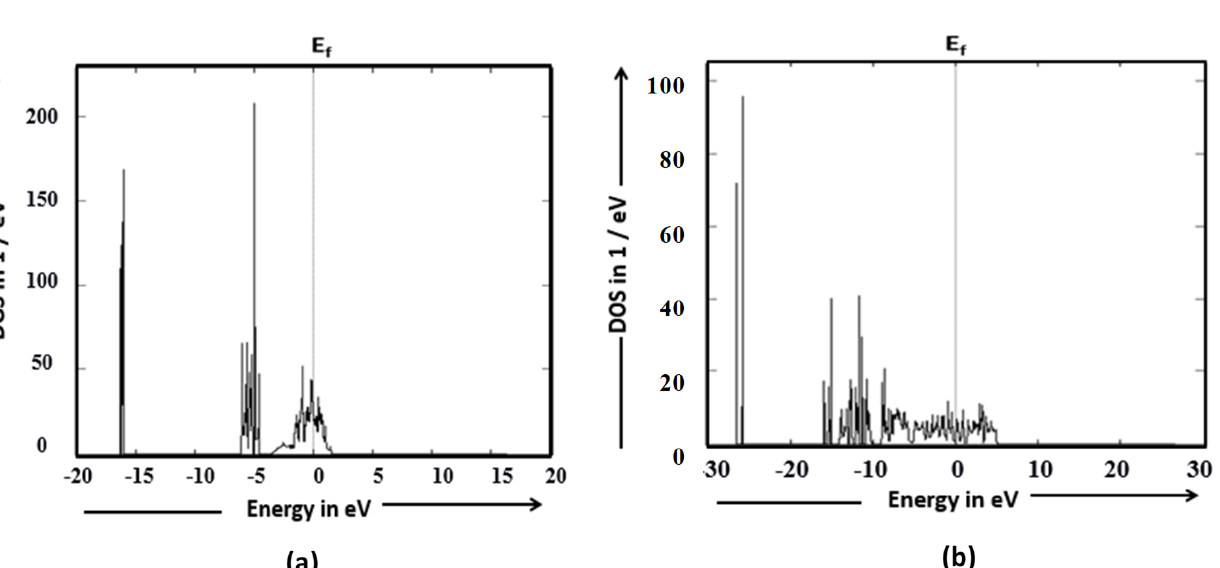
Figure 4. Variation in quantum capacitance (QC) for pristine unpolarized niobium nitride structures under bias voltage. The QC values obtained for both structures at different bias voltages are compared in Figure 4. It is found that quantum capacitance of Nb 2 N remains higher than Nb 4 N 3 for most of the bias voltage range. Although QC values for Nb 4 N 3 are lower than Nb 2 N, they are still high enough (Figure 4) for use as electrode material for supercapacitors. 3.2. Effect of Number of Layers In order to investigate the impact of increasing molecular layers in the crystal struc- ture, these calculations were repeated for up to three layers. The values of quantum ca- pacitance are found to increase with increase in number of layers for both Nb 2 N and Nb 4 N 3 , as shown in Figure 5a, b, respectively.